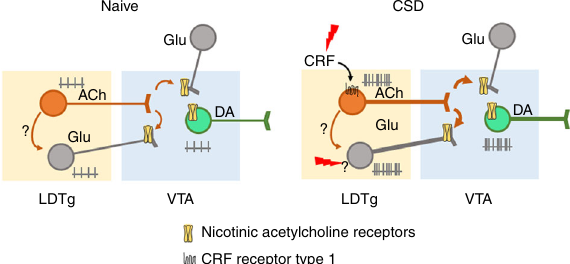
Fig. 6 Schematic model of the fi ndings. In naive conditions, LDTg excitatory projections regulate the fi ring and bursting activity of VTA DA